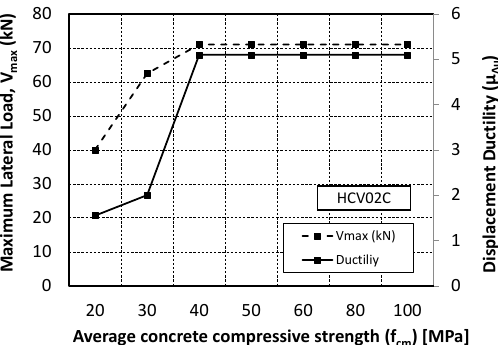
Average concrete compressive strength (f cm ) [MPa] Figure 12. Influence of secondary concrete in maximum lateral load and displacement Figure 12. In fl uence of secondary concrete in maximum lateral load and displacement ductility.